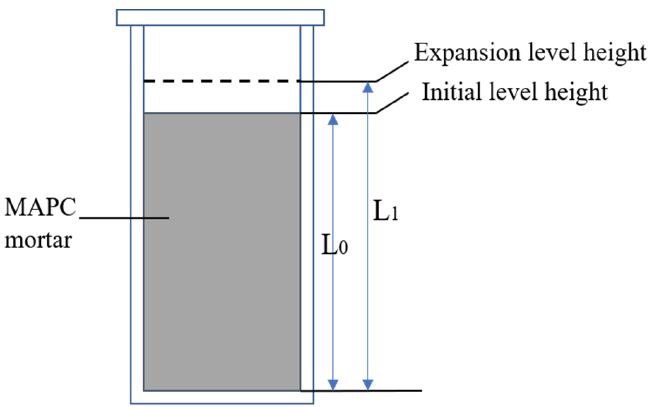
Figure 1. Testing apparatus of linear expansion of fresh MAPC mortar before setting.